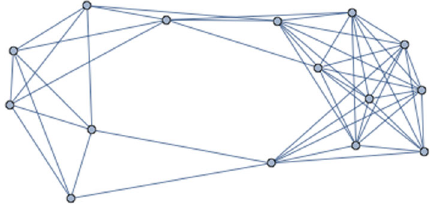
Fig. 12 A graph made by connecting the points with relative distances smallerthan1 . 5.ThedataisthesameoneusedforFig.11.Thischoiceof thedistancecut-offismadebecauseaone-dimensionalcycleisexpected to exist at this scale, seeing the right of Fig. 11